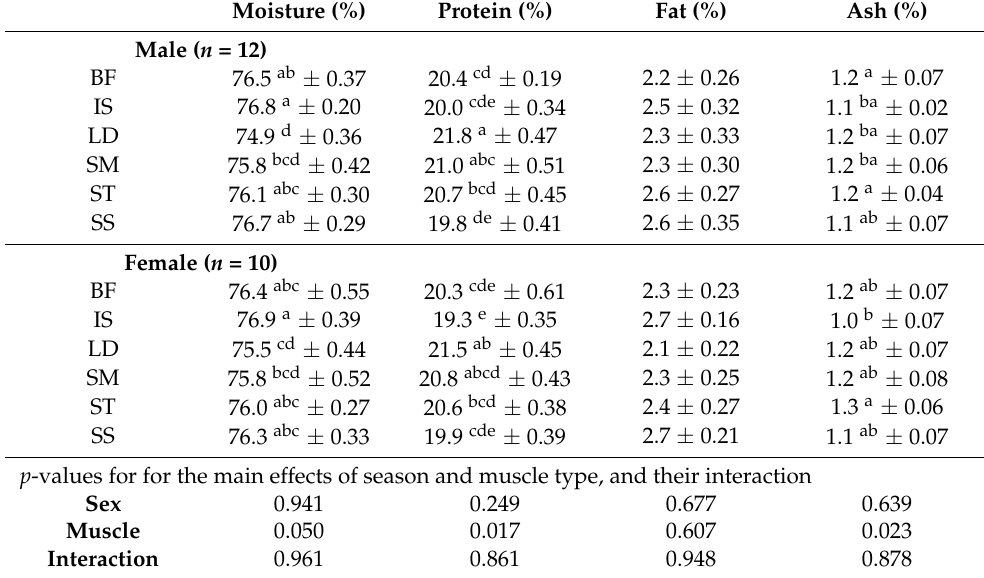
Table 5. Mean values ( ± standard errors) and least significant differences (LSD) for moisture, protein, fat and ash values for the longissimus dorsi (LD), biceps femoris (BF), semimembranosus (SM), semitendinosus (ST), supraspinatus (SS) and the infraspinatus (IS) muscles from male and female red hartebeest from